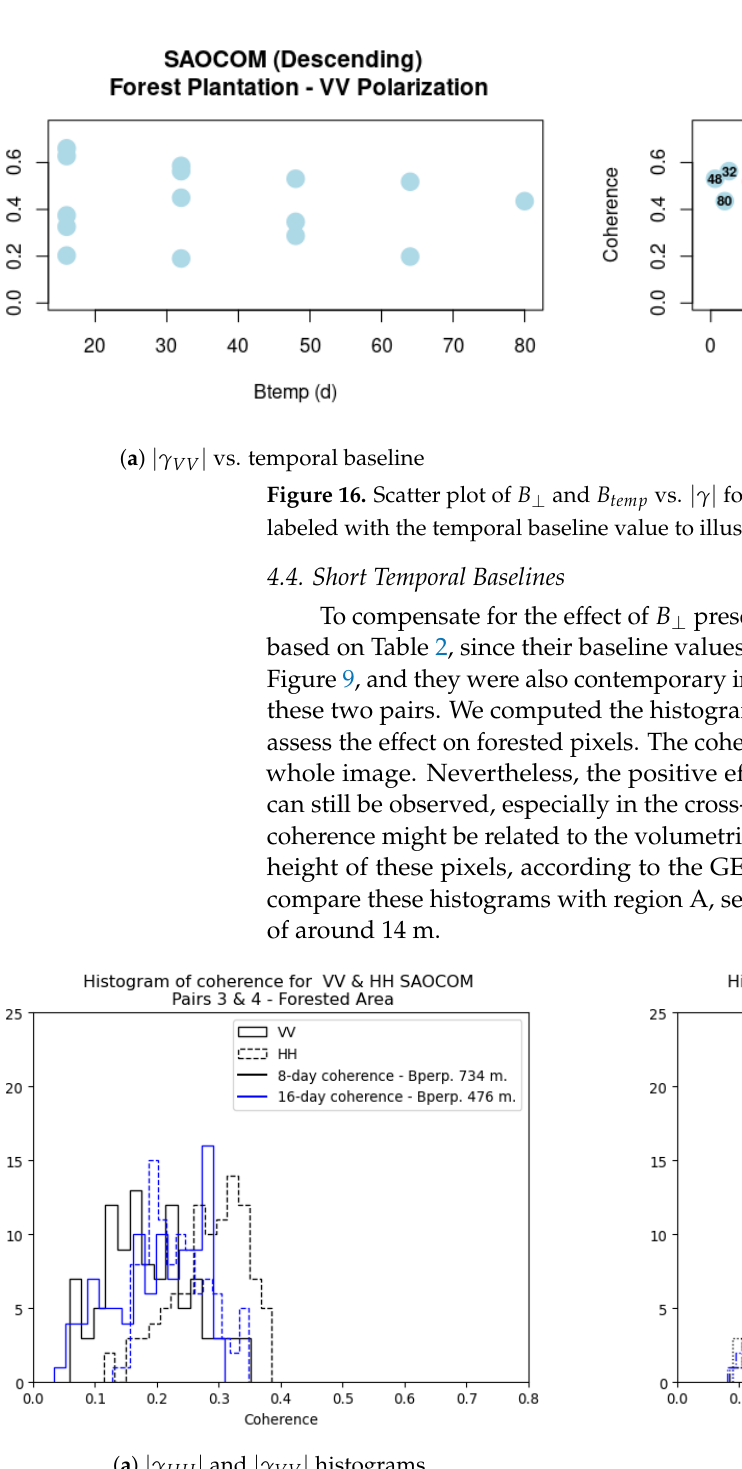
Figure 17. Histograms of | γ | for SAOCOM-1 at 8 and 16 days separation in region C, Figure